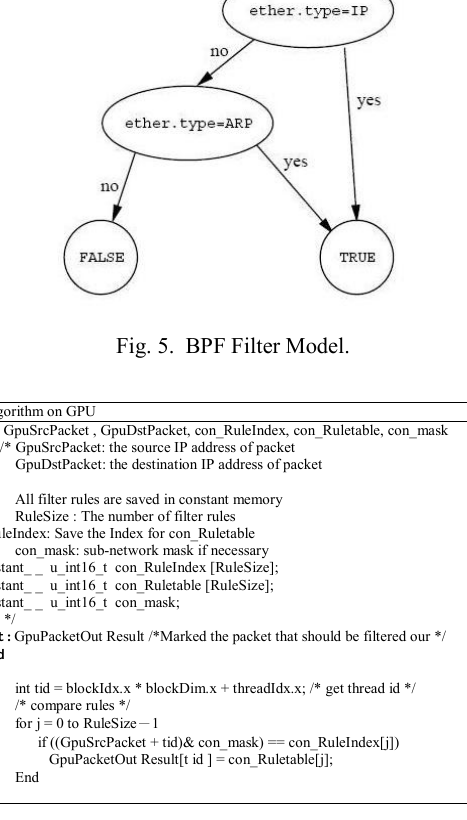
Fig. 6. GPU-based BPF algorithm.